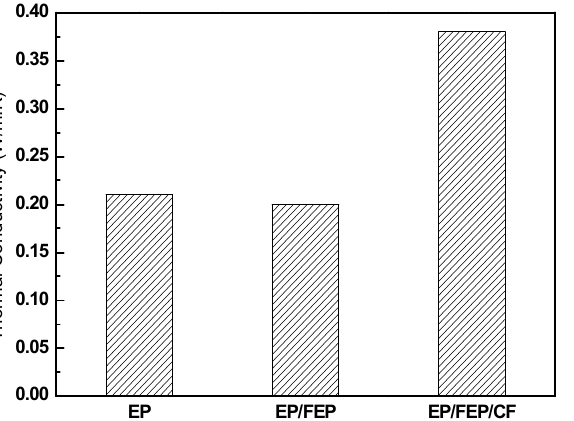
Figure 6. Surface SEM images of the A-CF/EP composites after 60,000 ( a ) and 120,000 ( b – d ) abrasion cycles at different magnifications.